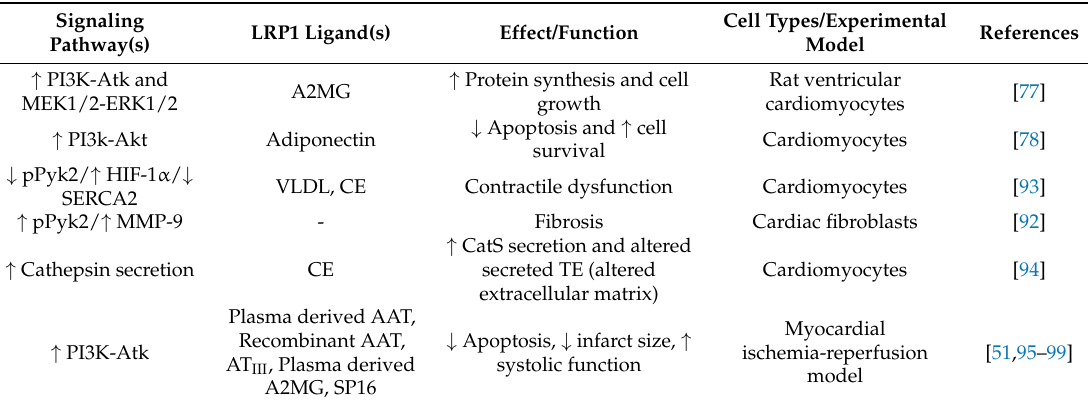
Table 2. LRP1-mediated signaling in acute myocardial ischemia and infarction.